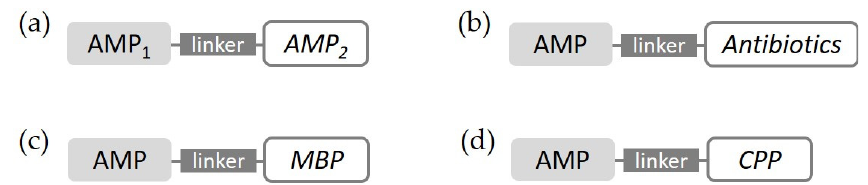
Figure 4. Conjugation system. ( a ) Hybrid peptide, ( b ) antibiotic–peptide conjugate, ( c ) AMPs conjugated with membrane-binding peptides (MBP), and ( d ) AMPs conjugated with cell-penetrating peptides (CPPs).